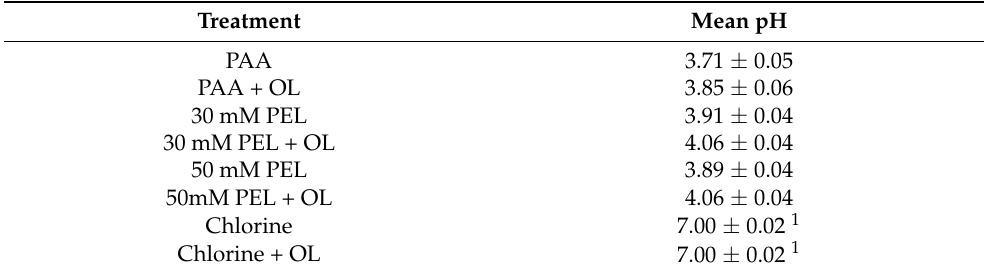
Table 1. Mean pH ± standard deviation ( n = 12) of wash treatments.